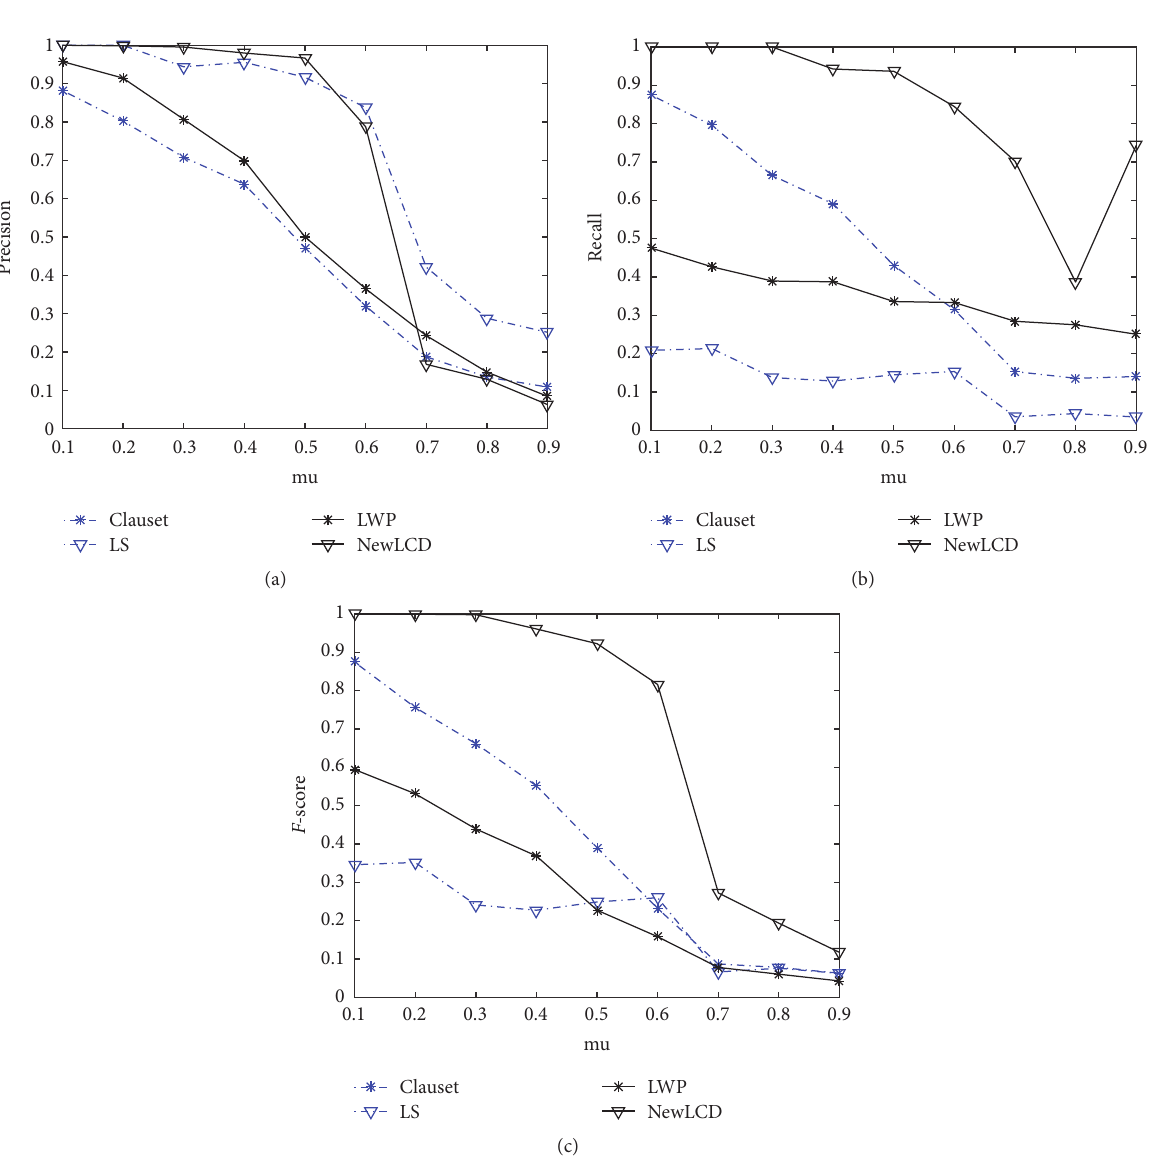
Figure 4: Comparison of